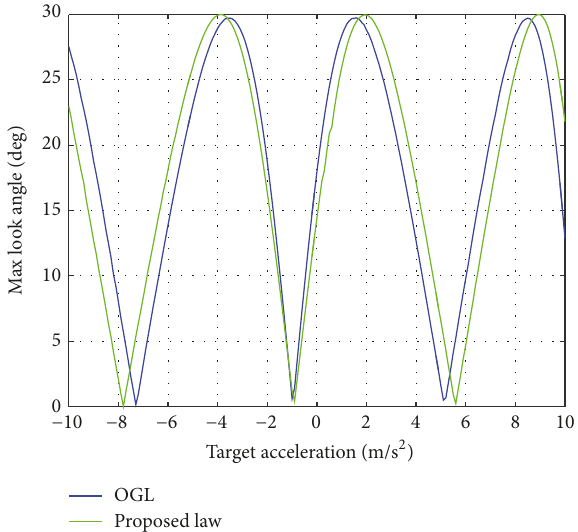
Figure 11: Max look angle of OGL and proposed law under different acceleration of target.